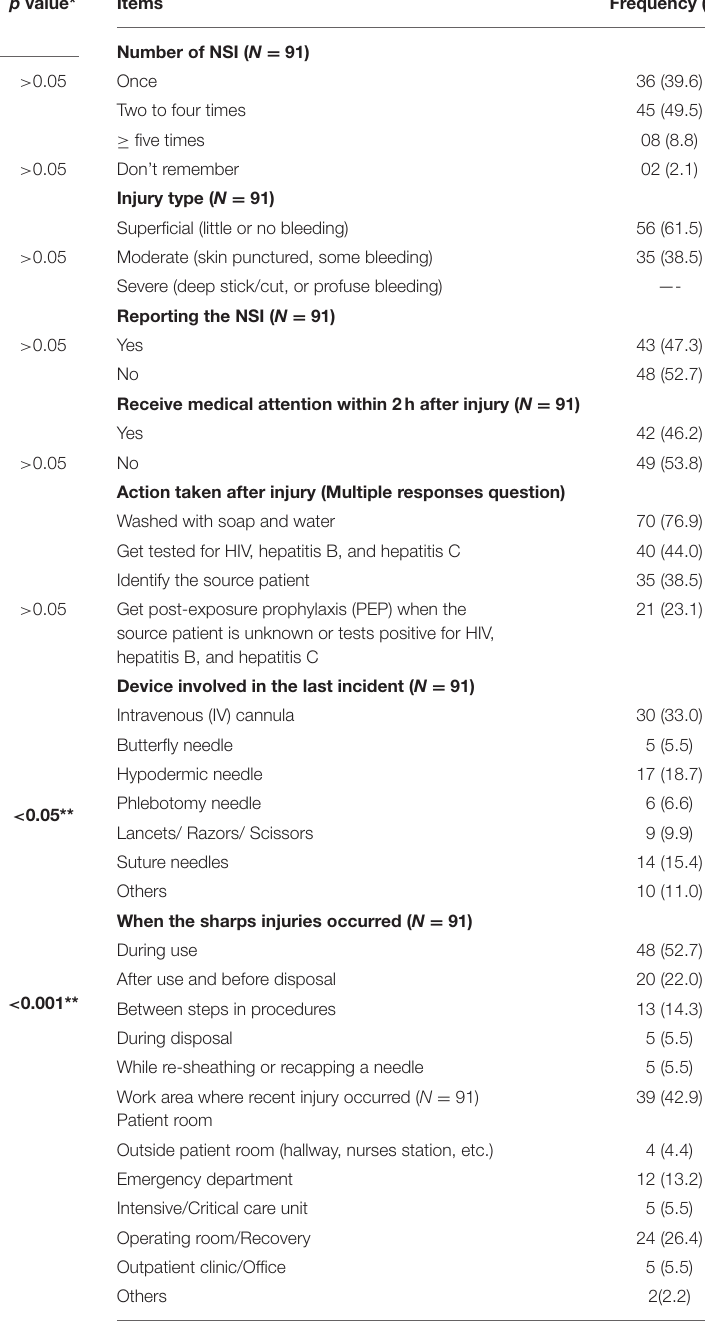
TABLE 2 | Socio-demographic characteristics among the HCWs. TABLE 3 | Experiences regarding NSIs.